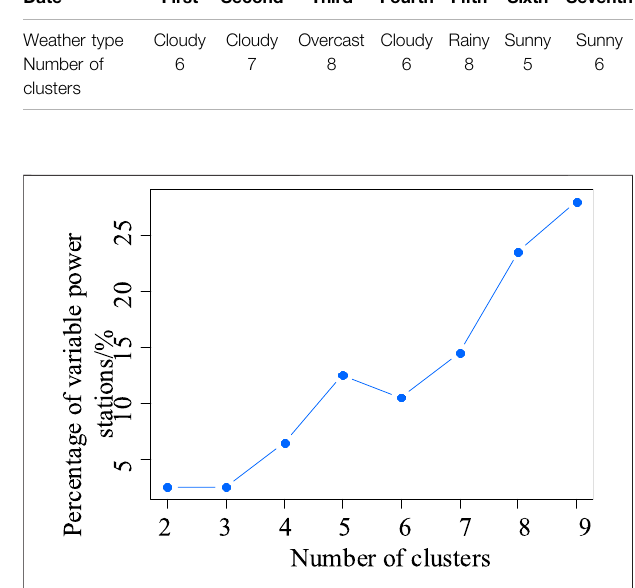
FIGURE 5 | Change curve of variable power station proportion under different clustering